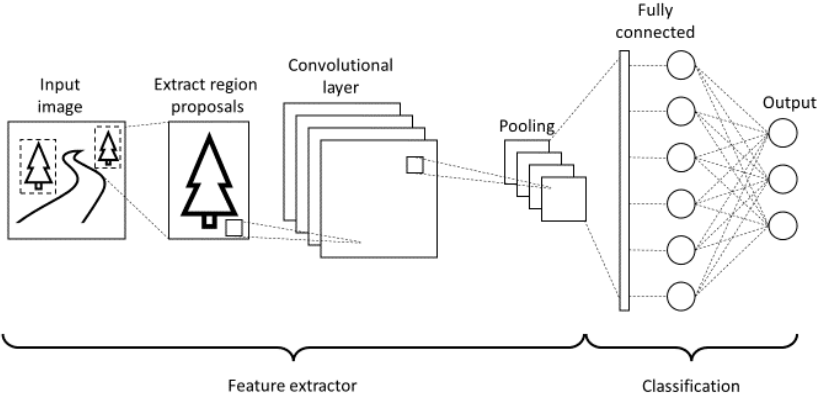
Figure 4. Simplified diagram of the structure of an R-CNN.